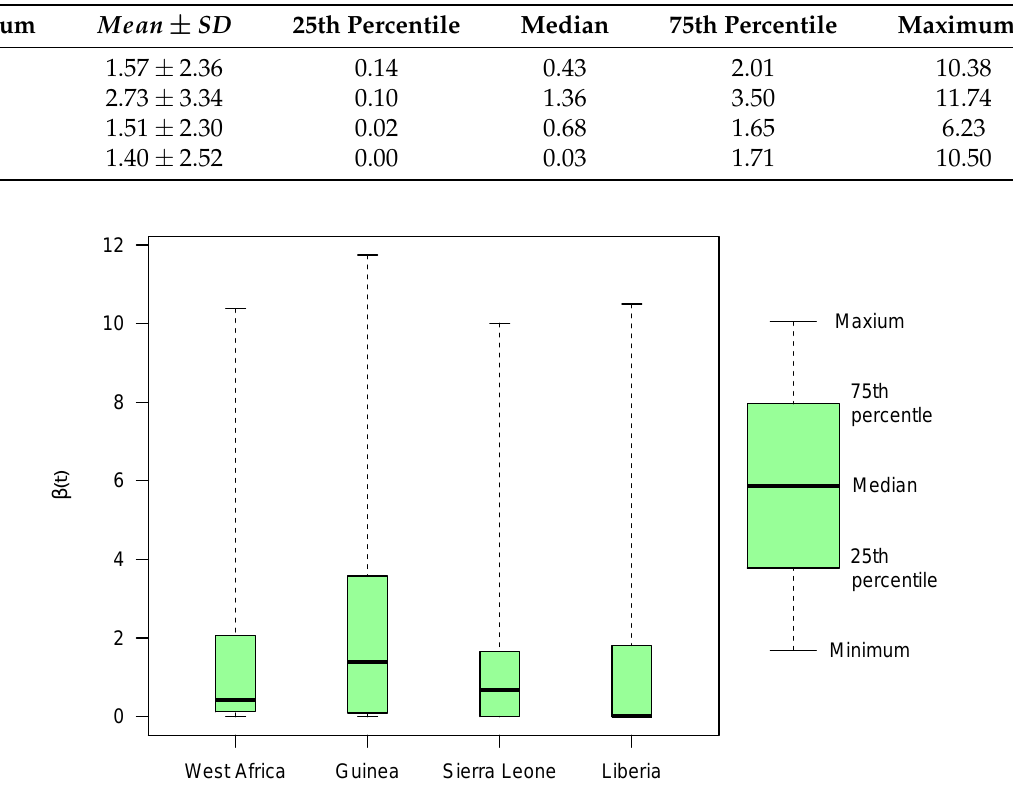
Figure 4. Box-and-Whiskers plot for estimates of β ( t ) using available incidence data for the 2014–2015 Ebola epidemic of West